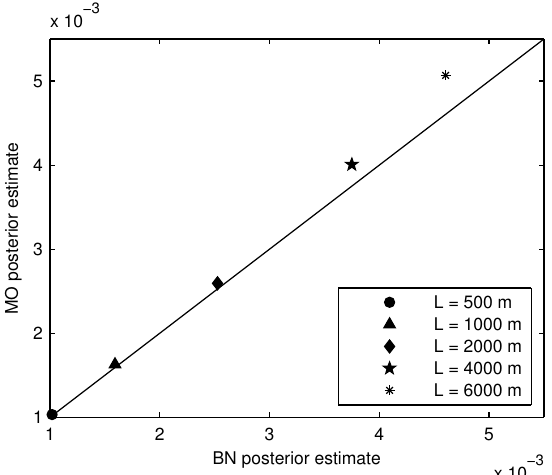
Figure 15. Comparison of BN and MO posterior segment failure probability estimates (shown together with the 1:1 line, which represents perfect